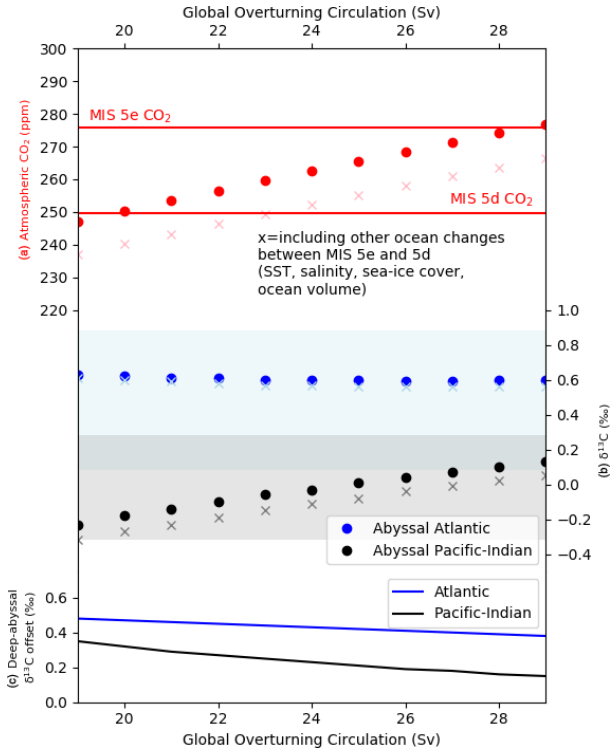
Figure 13. Sensitivity of atmospheric CO 2 concentration and ocean δ 13 C to a downward variation in global ocean circulation parameter (cid:57) 1 in MIS 5e in SCP-M. The x axis shows the range of variation in (cid:57) 1 in Sv and the y axes show the model results for (a) atmo- spheric CO 2 and (b) abyssal ocean δ 13 C in each basin. Shaded ar- eas are the ± standard deviations for abyssal δ 13 C in MIS 5e. Panel (c) shows the deep–abyssal δ 13 C offset for each basin. Atmospheric CO 2 in MIS 5e and 5d is shown for reference. The “x” symbols in (a) and (b) show the same experiment including other changes in the ocean across MIS 5e–5d: SST, salinity, Antarctic sea-ice cover, ocean volume and coral reef carbonate production. Southern Ocean biological export productivity is not varied in this